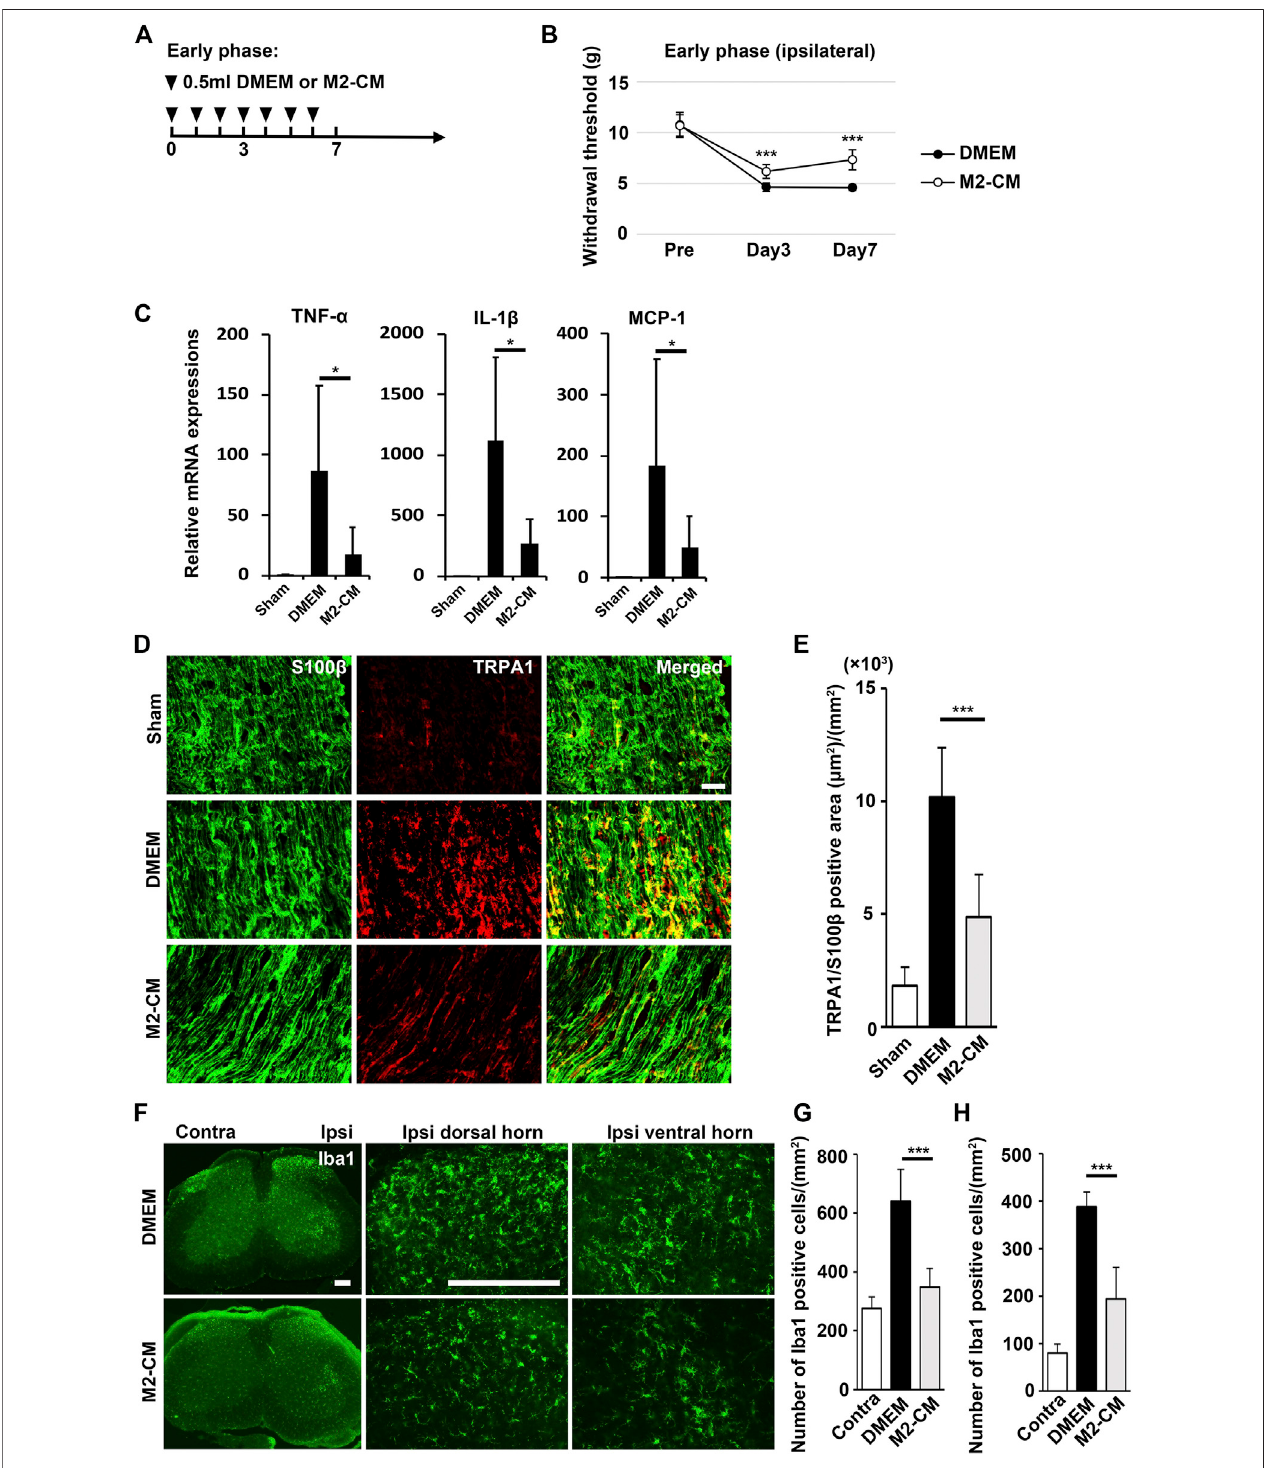
FIGURE 9 | Analgesic effect of M2-CM. (A) Time course of M2-CM treatment in the early phase model. (B) The ipsilateral paw withdrawal thresholds in the early phasemodel.Student ’ s t -test( n =10ineachgroup). (C) qPCRanalysisofthesciaticnerves3 daysafterPSLfortheindicatedmRNAs.Student ’ s t -test( n =4 – 6). (D) The immuno fl uorescentstainingofTRPA1,S100 β inSCN.Scalebar:50 μ m. (E) QuantitativeanalysisoftheTRPA + S100 β + area. (F) Theimmuno fl uorescentstainingofIba1 in the ipsilateral horn of the L3/4 SP. Scale bar: 200 μ m. (G,H) Quantitative analysis of the number of Iba1 + cells. Student ’ s t -test ( n = 7 – 9, per group). Data represent the mean ± SD; *** p < 0.001.